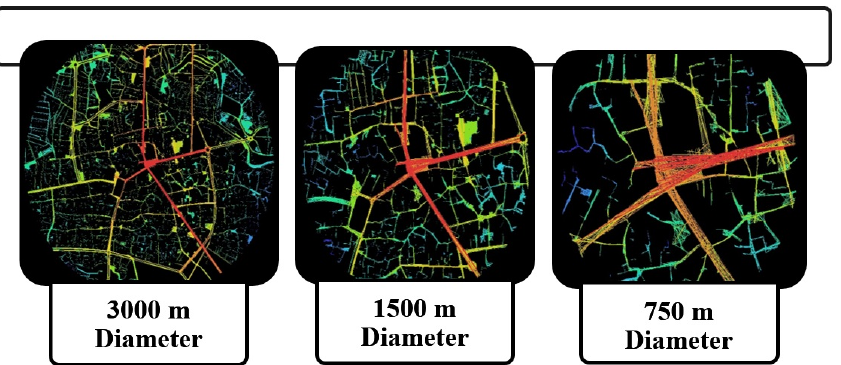
Figure 4. The spatial configuration analysis of the axial map graphs in different cases using the Space Syntax method, performed using the Depthmap software.